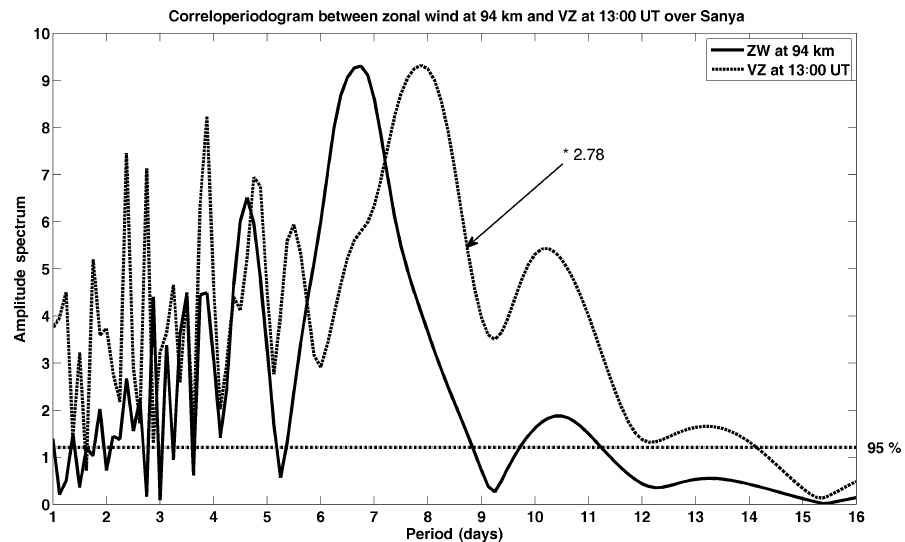
Figure 8. The correloperiodogram amplitude spectra of the zonal wind at 94km (the solid line) over Fuke and the vertical drift of the F-layer virtual height at 13:00UT (the dotted line) over Sanya. The horizontal dotted lines denote the 95% confidence